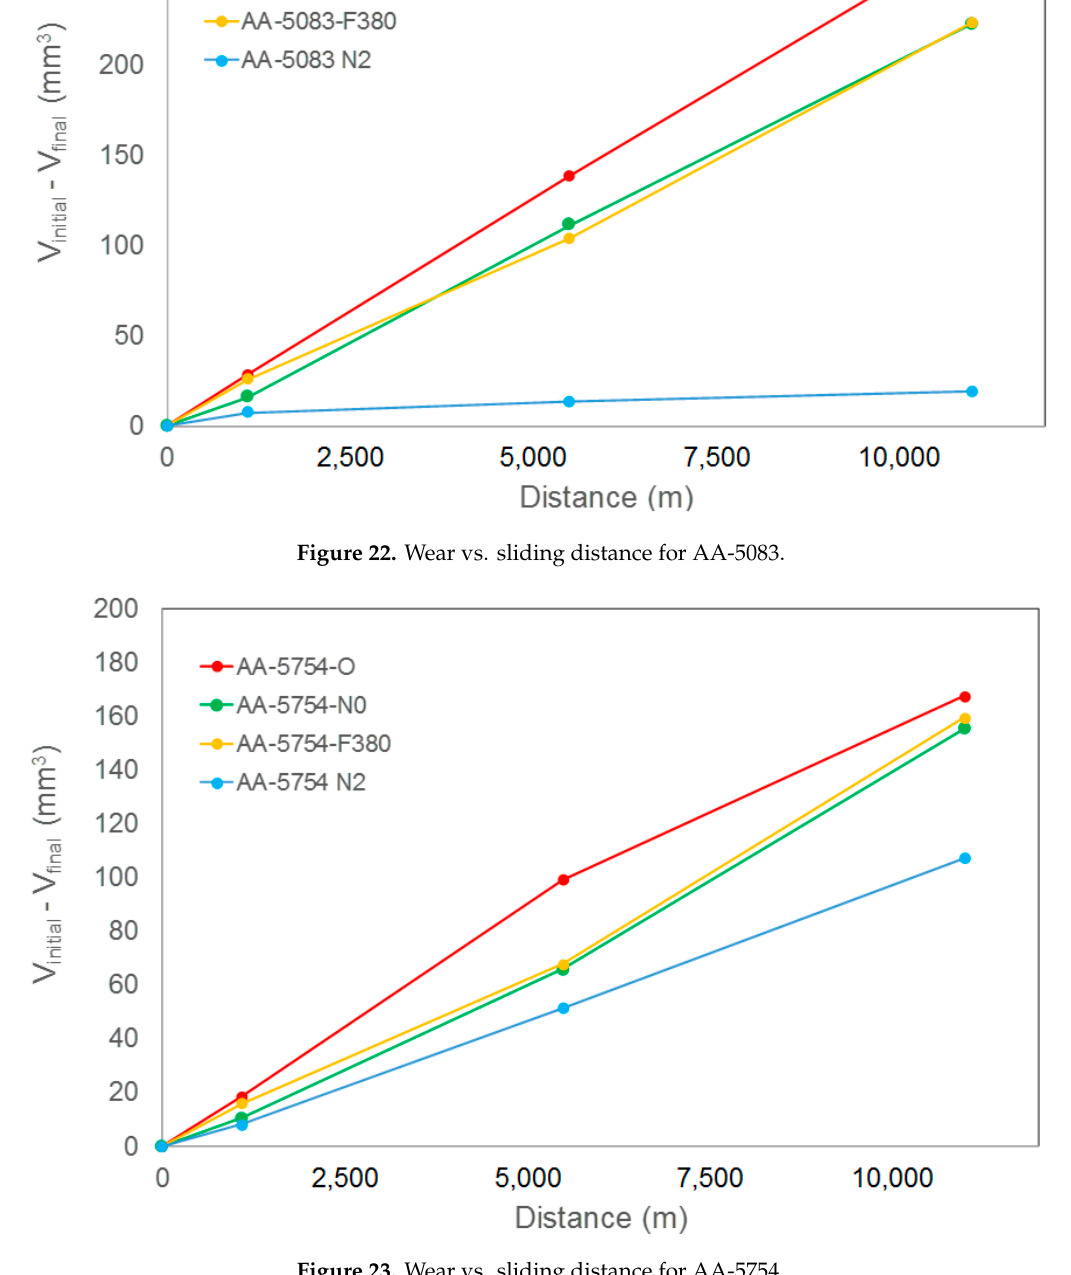
Figure 23. Wear vs. sliding distance for AA ‐ 5754.